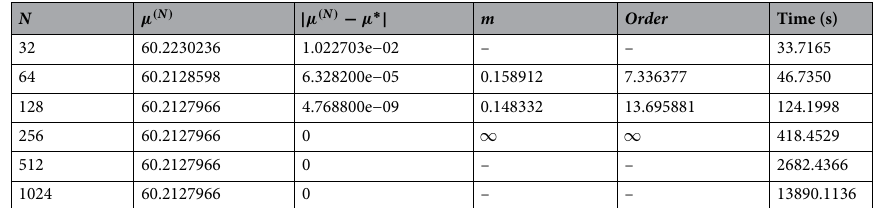
87 Rb obtained by implementing Algorithm 3.2, where